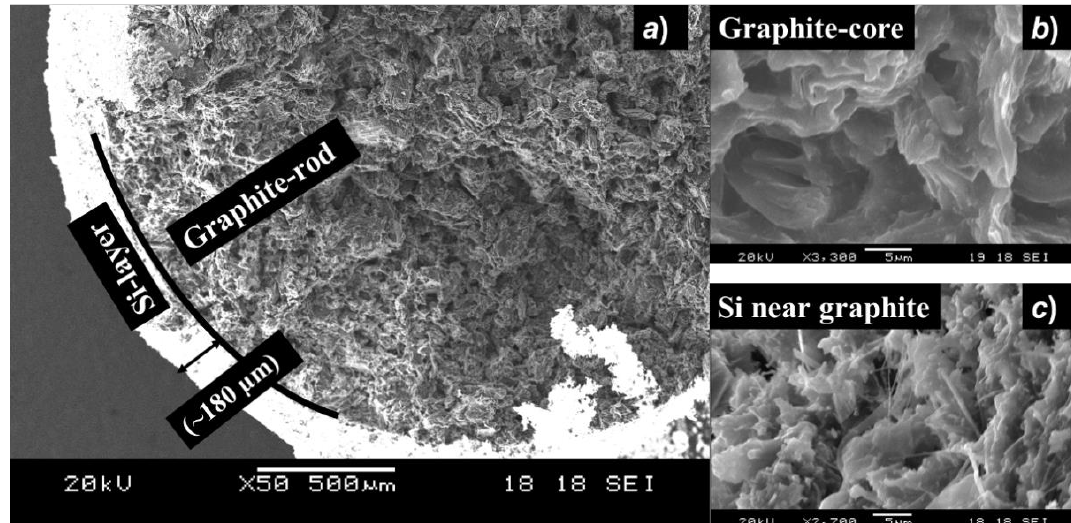
Figure 5. ( a ) Cross-sectional SEM image of the Si-coated graphite rod after electrochemical reduction of nano SiO 2 at low potential and washed with HCl, ( b ) magnified image of the graphite core, ( c ) magnified image of the Si-layer close to the graphite-rod.